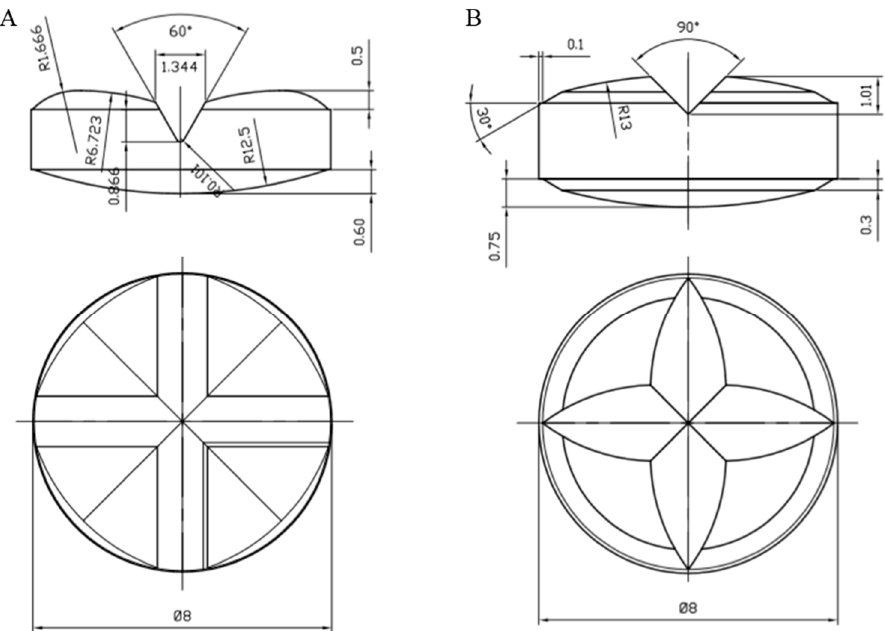
Figure 2. Technical drawings of scored tablets (side and top views) from EBT ( A ) and TBT ( B ) punches (dimensions are expressed in mm).